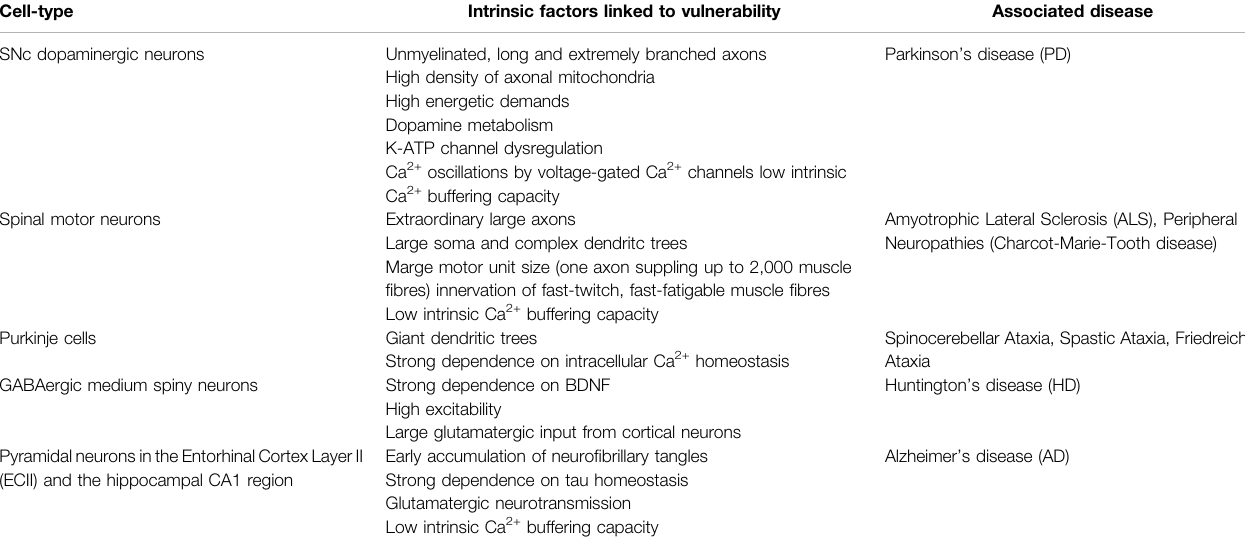
TABLE 4 | Most affected neuron populations in selected neurological